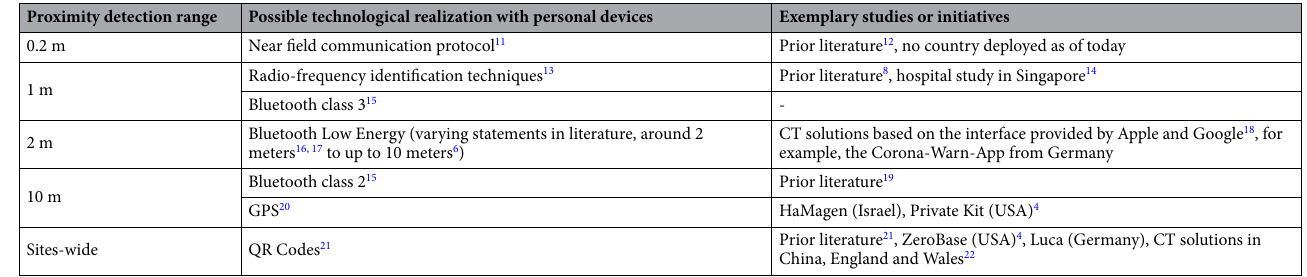
Table 1. Simulated proximity detection methods and their possible realization with widespread sensors for personal